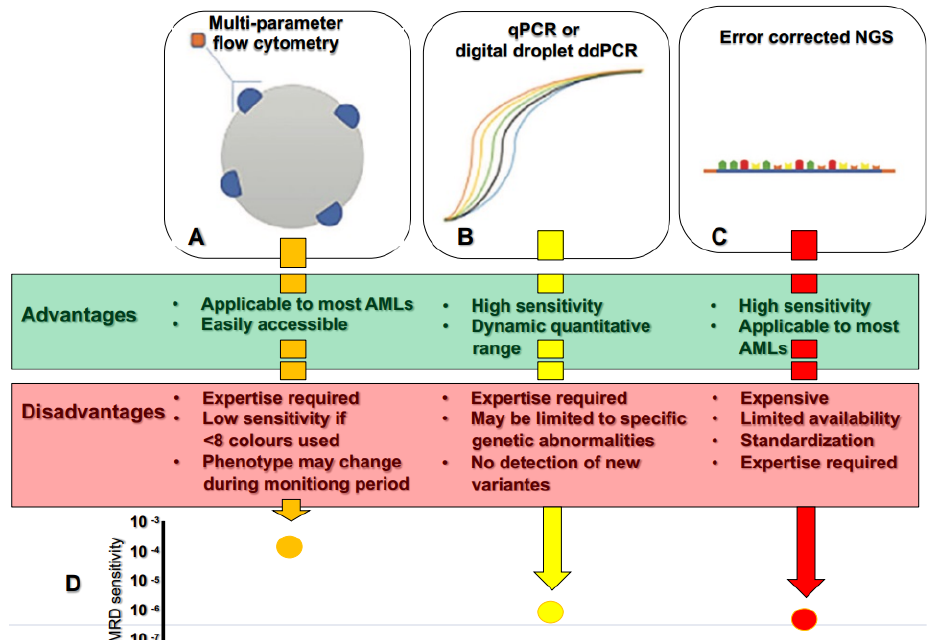
Figure 1. Summary of the advantages and disadvantages of methods of MRD assessment: ( A )—Multi- parameter flow cytometry; ( B )—Quantitative polymerase chain reaction (PCR) and droplet PCR; ( C )—Next generation sequencing; ( D )—The different sensitivity MRD assessments comparing the ability of each method to detect a single AML cell amongst normal haemopoietic cells. Sensitivities are as follows: Flow cytometry, 1 in 10,000; qPCR, 1 in 1,000,000; ddPCR, >1 in 1,000,000; NGS, 1 in 1.000.000.